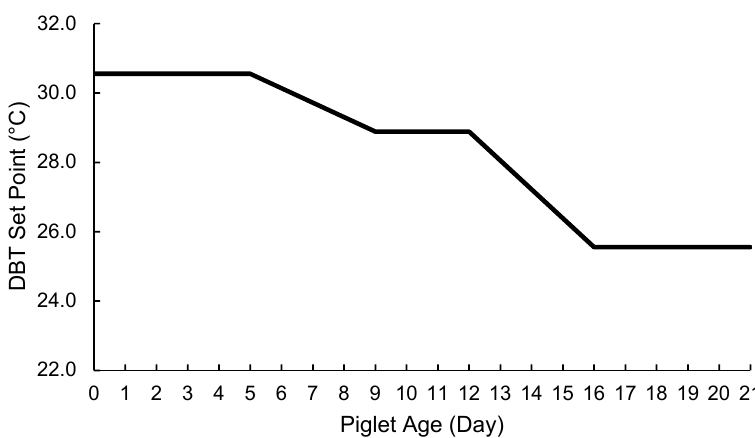
Figure 4. Dry-bulb temperature (DBT) set point curve by piglet age that was used to control the proportional output of the SEHMs.